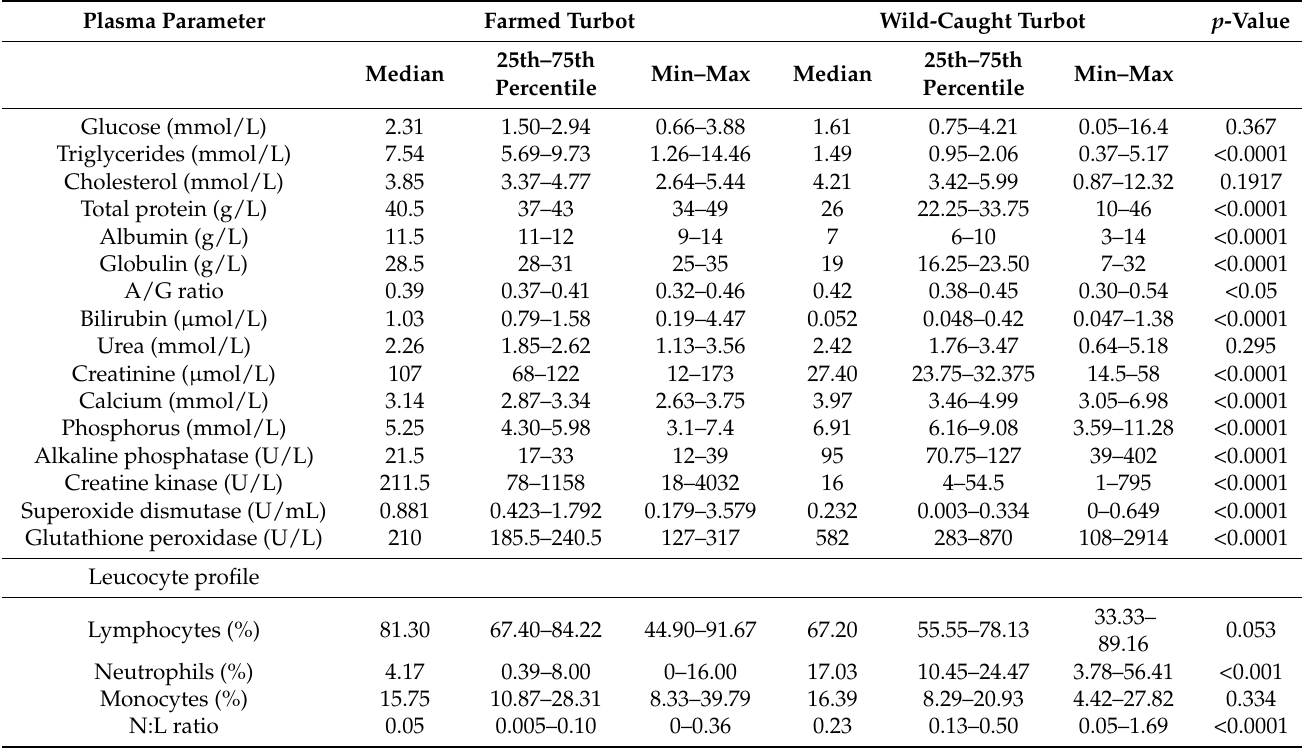
Table 2. Biochemistry and leukocyte profiles of the farmed and the wild-caught turbot Scophthalmus maximus from the northern Adriatic Sea.